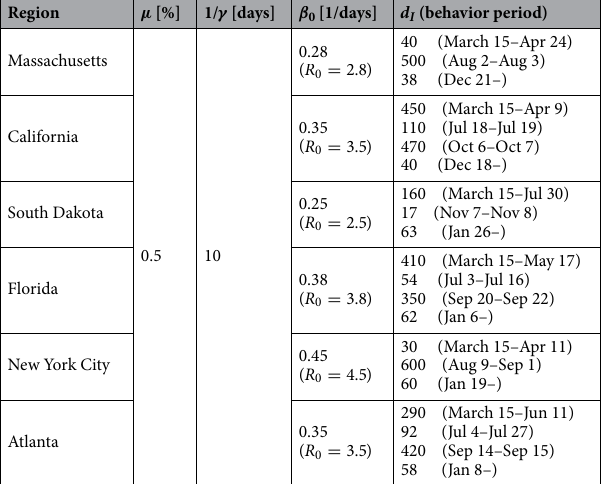
Table 1. Parameters for the four states and two cities for the 2020 COVID-19 pandemic. The initial basic reproduction number, R 0 = β 0 γ , represents the expected number of secondary infections if an infectious individual was placed in the population, without any social preventative measures. d I values represent its constant value in each of the corresponding behavioral periods. Smooth transitions between constant values of d I were applied.